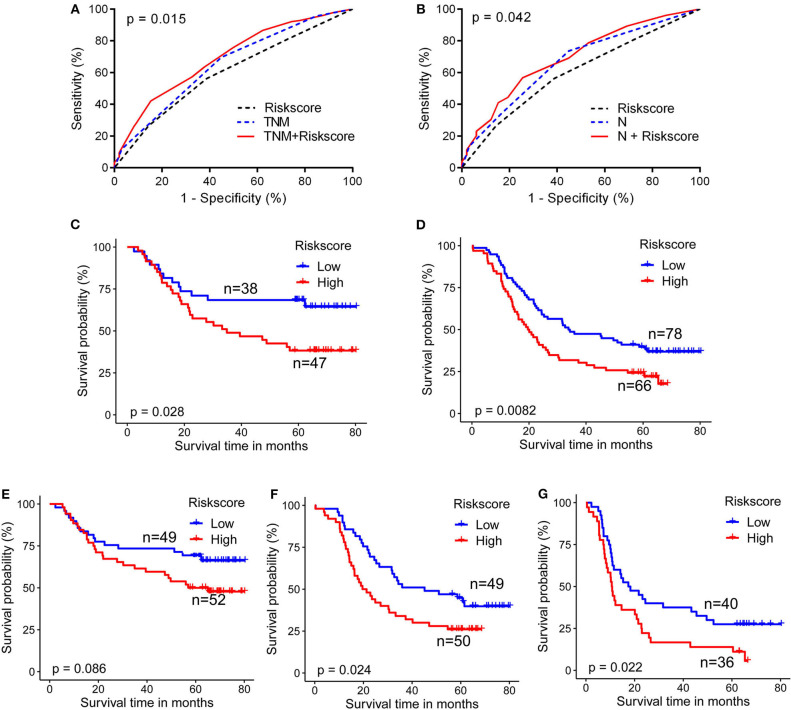
Metabolite-based risk score improves prognostic performance for ESCC patients. (A) Combination of risk score with TNM stage (B), or with N stage (G) significantly improved the predictive accuracy of 5-year survival rate. ESCC cases classified according to TNM II (C), TNM III (D), N1 (F), and N2 (G) stages were significantly stratified by risk score. Cases from N0 (E) showed a trend for stratification by risk score. DeLong test for AUC in ROC curves and log-rank test for Kaplan-Meier survival curves were assessed, p < 0.05 was considered significant.